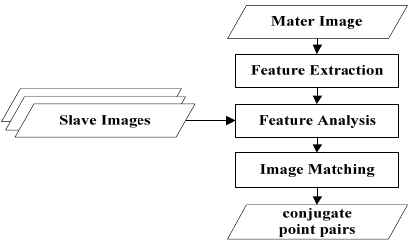
Figure 2. Workflow of the proposed scheme